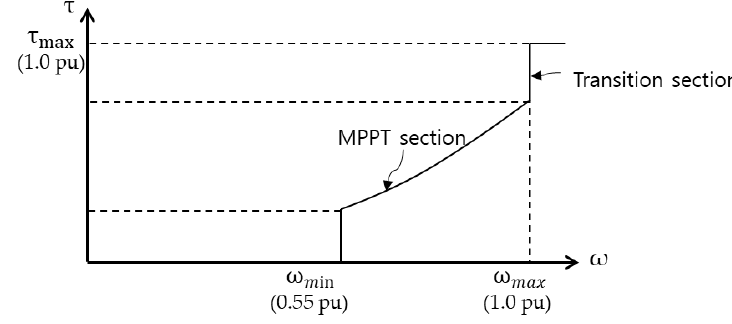
Figure 3. Torque–rotor speed curve on the MPPT.